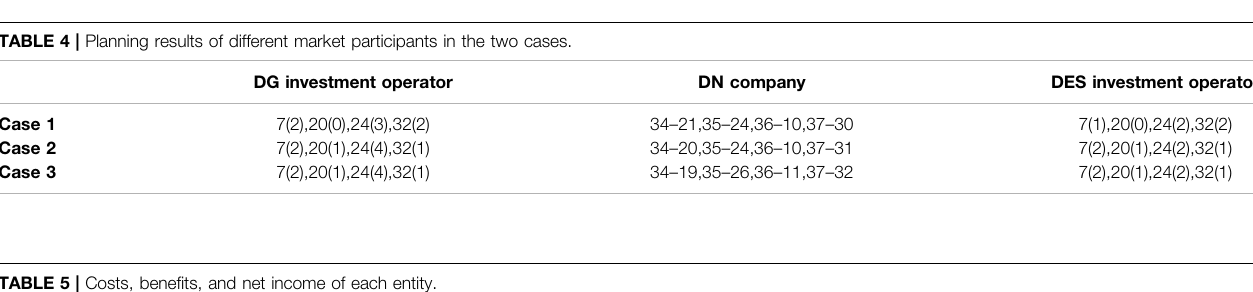
TABLE 5 | Costs, bene fi ts, and net income of each